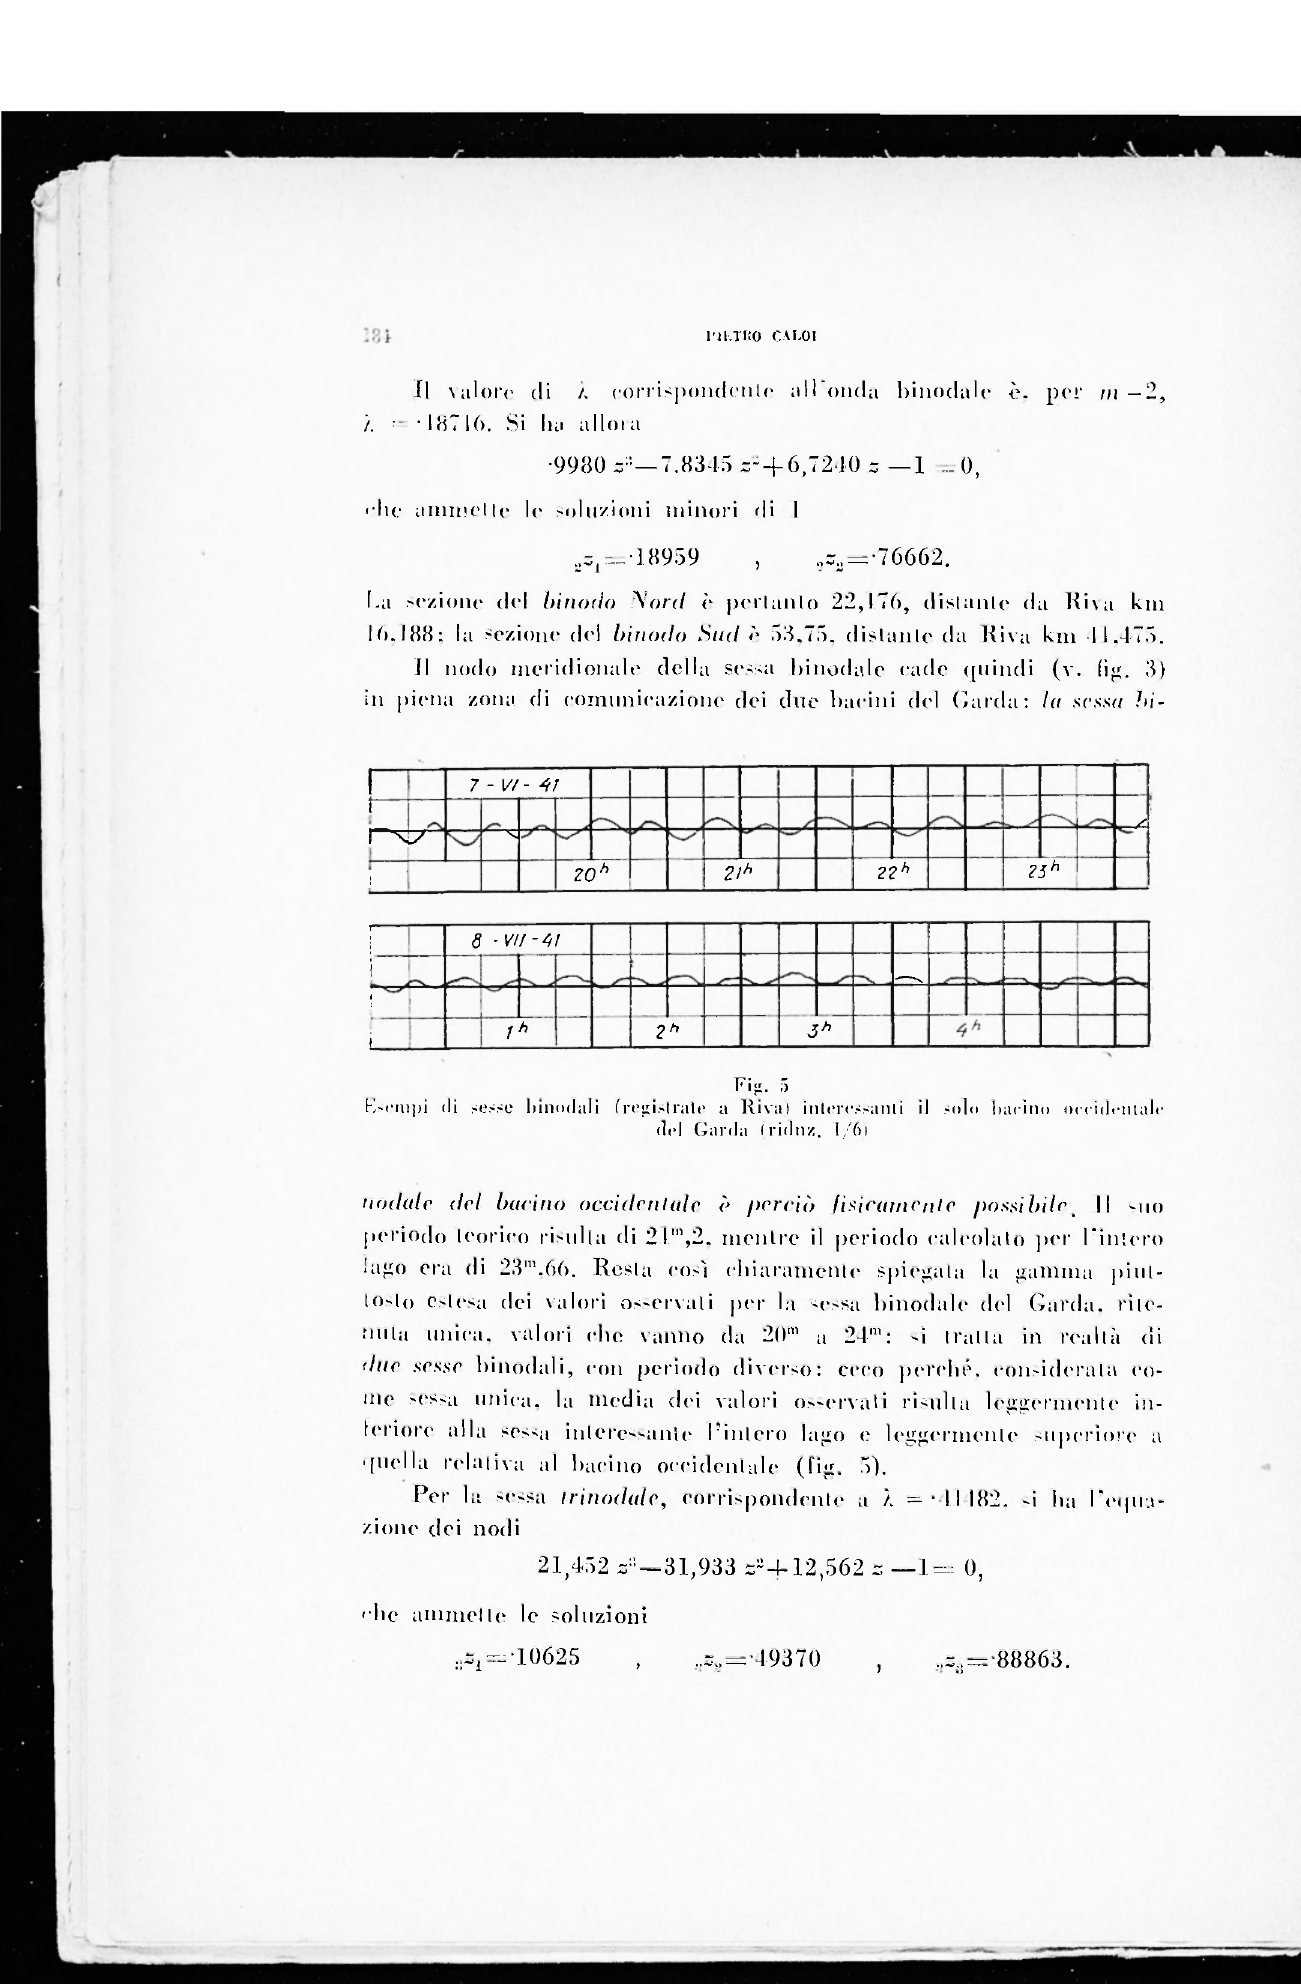
Fig. 5 Esempi di sesse binodali (registrate a Riva) interessanti il solo bacino occidentale del Garda Iridnz.